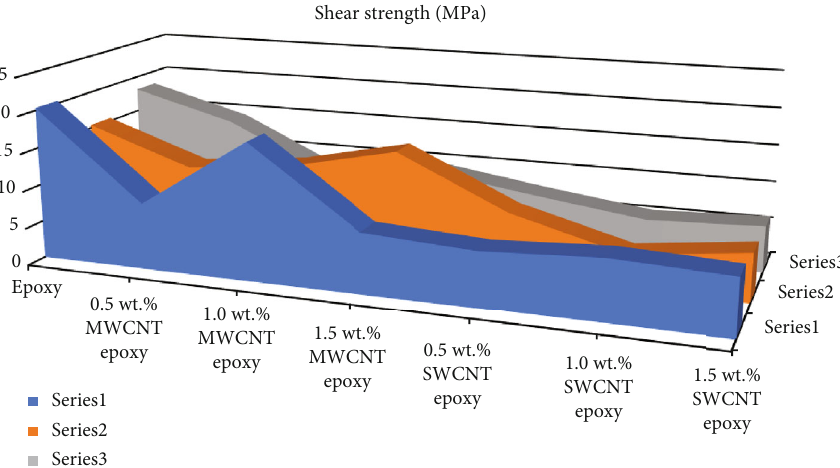
Figure 8: Average shear strength results for CNT-epoxy composite specimens obtained from the short-beam test.